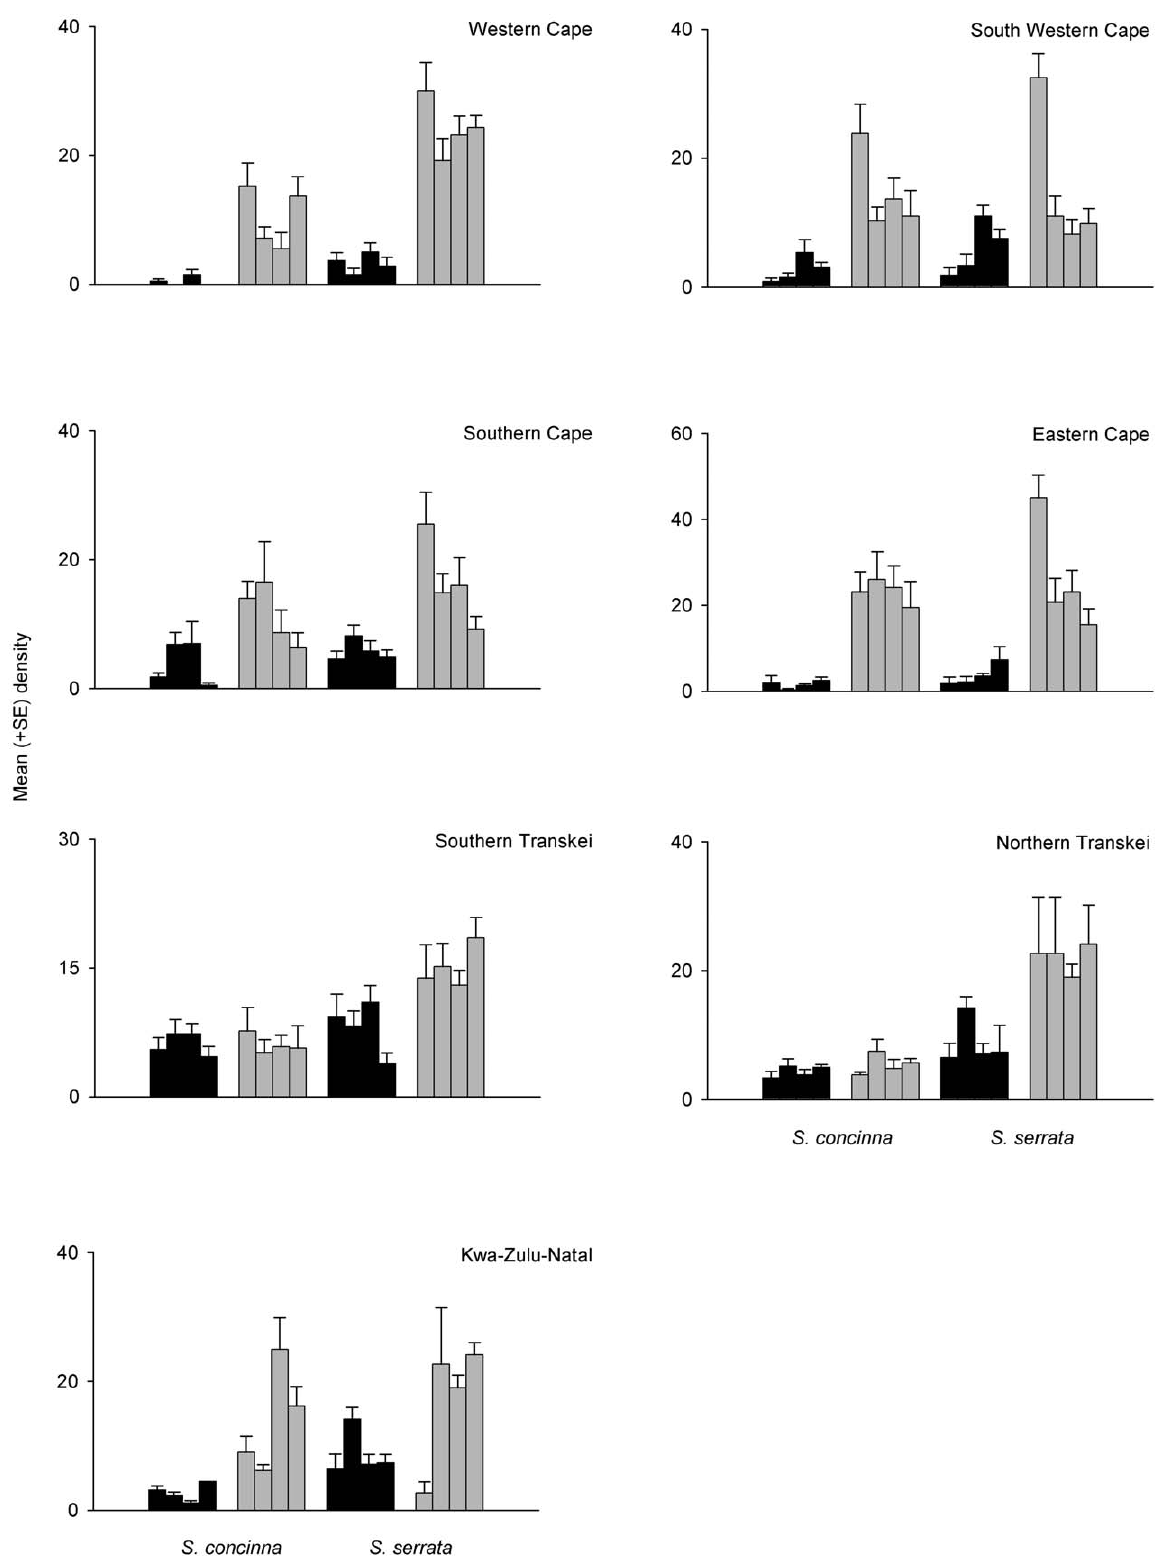
Figure 2. Mean ( + SE; n =6) density of adult Siphonariaconcinna and S.serrata in small (black bars) or large patches (grey bars) in 7 different regions (Western Cape, South Western Cape, Southern Cape, Eastern Cape, Southern Transkei, Northern Transkei and Kwa-Zulu Natal).